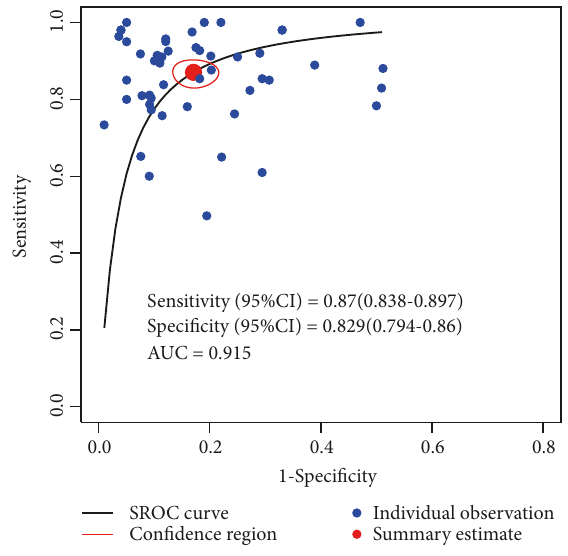
Figure 2: SROC curve for overall studies, AUC =